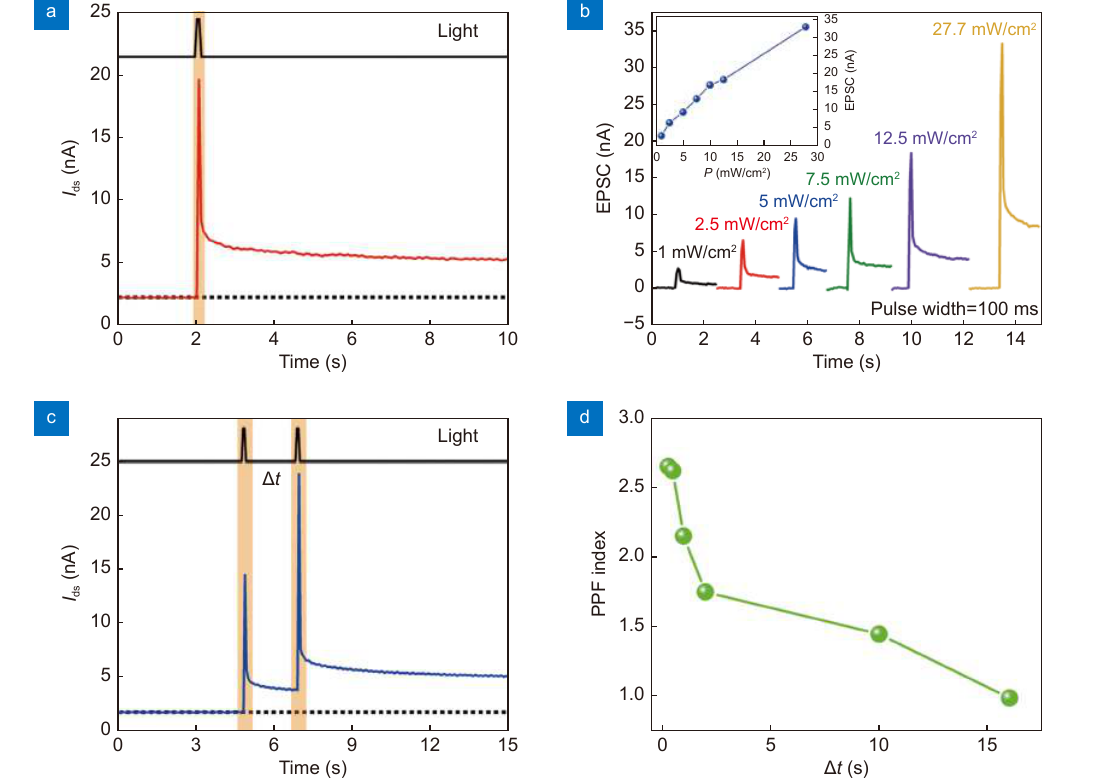
Fig. 3 | STP characteristics of the MoS 2 synaptic transistor. ( a ) The transient current response induced by an optical pulse of 50 ms. ( b ) The EPSC curves under different laser power densities (pulse width: 100 ms). Inset: The dependence of EPSC with differnent laser power densities (P). ( c ) The instantaneous current responses triggered by a pair of optical pulses (pulse width = 50 ms, pulse interval Δ t = 2 s). The black dashed line represents the initial current in (a) and (c) without optical stimuli. ( d ) The PPF behaviors at different Δ t